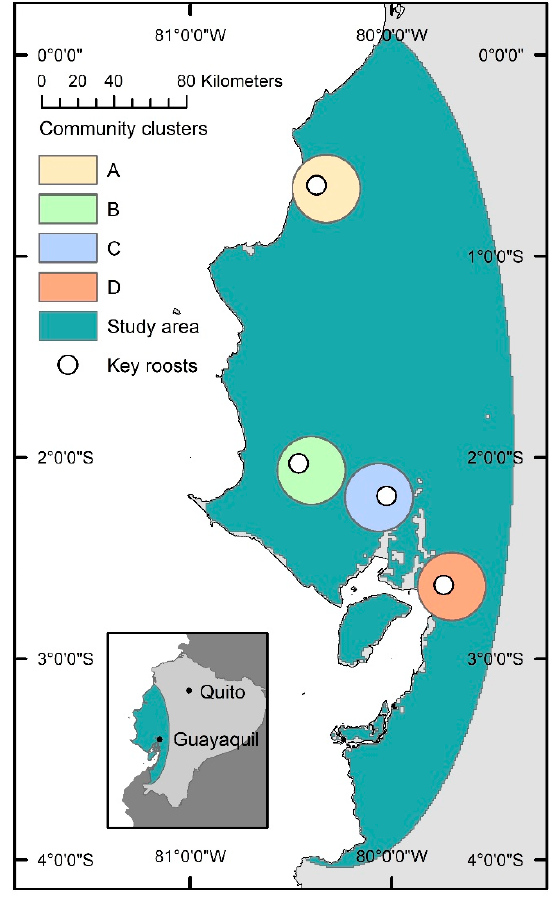
Figure 1. Interviews about parrot ownership and capture were conducted in 12 communities, grouped into four clusters (A, B, C, and D) near key Lilacine Amazon roost sites. Each cluster contains three communities <10 km apart.